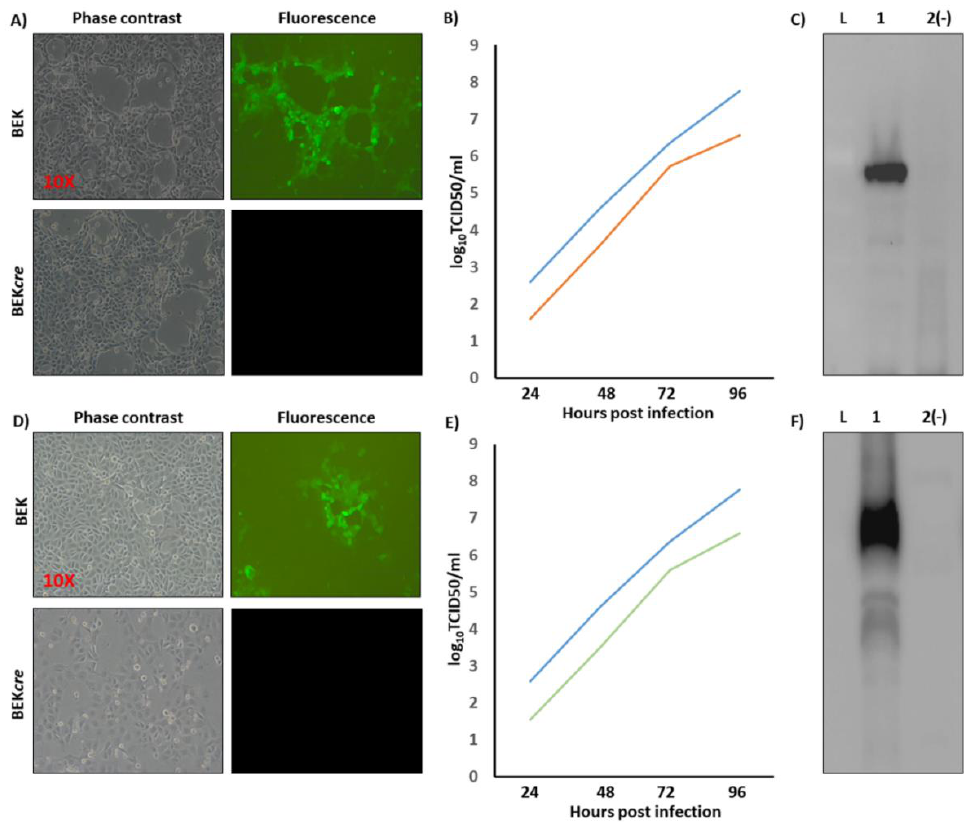
Figure 2. Reconstitution and characterization of recombinant viruses. Representative phase contrast and fluorescent microscopic images of plaques formed by viable reconstituted recombinant BoHV-4-A-CMV-NiV-F ∆ TK ( A ) and BoHV-4-A-CMV-NiV-G ∆ TK ( D ) after the corresponding BAC DNA electroporation into BEK cells or BEK cre (Magnification, × 10). Replication kinetics of BoHV-4-A-CMV-NiV-F ∆ TK ( B ) and BoHV-4-A-CMV-NiVG ∆ TK ( E ) growth on BEK cells, compared with those of the parental BoHV-4-A isolate. The data presented are the means ± standard errors of triplicate measurements ( p > 0.05 for all time points as measured by Student’s t -test). ( F ) Western immunoblotting of cells, infected with BoHV-4-A-CMV-NiVF ∆ TK (1) ( C ) and BoHV-4-A-CMV-NiVG ∆ TK (1) ( F ). The lanes were loaded with 20 µ g of protein extract. Negative control (2( − )) was established with BoHV-4-A infected cells. (L) mass ladder.